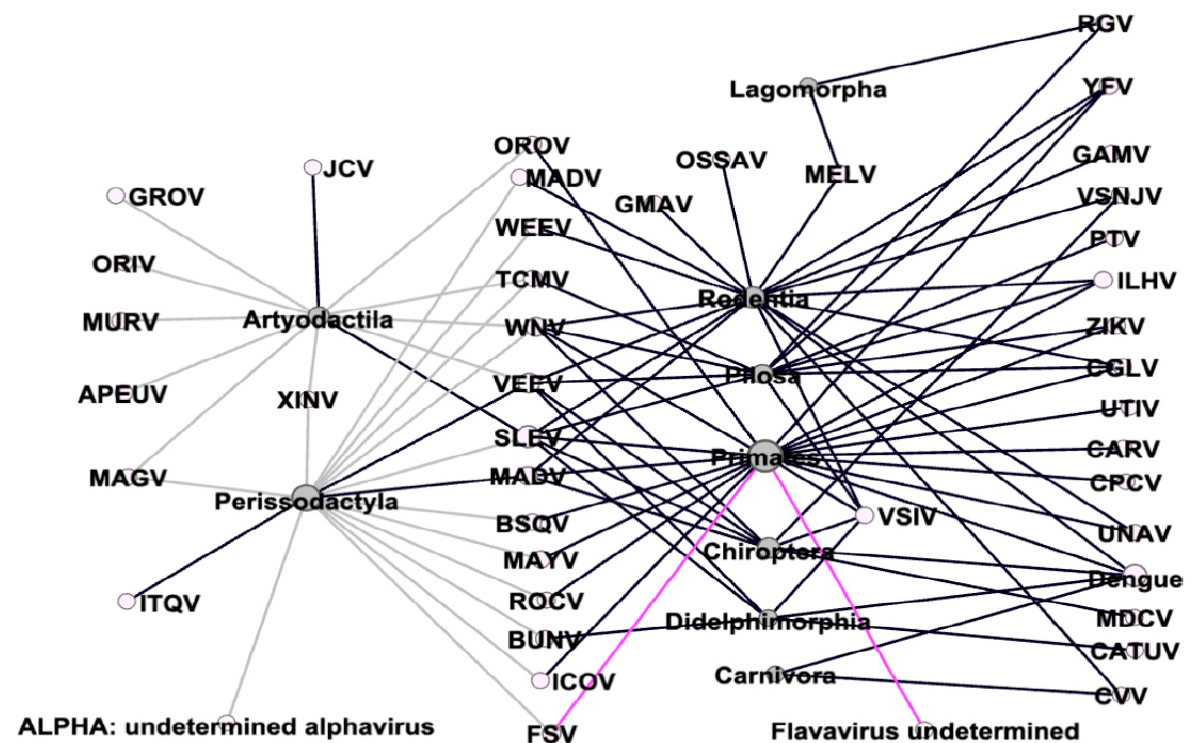
Figure 4. Arbovirus host network in mammals in the Neotropics. Legend: grey link: eomestic envi- ronment, black link: wildlife environment, pink link: zoological settings, grey circles: mammal or- ders, white circles: arbovirus. Note: Apeu virus—APEUV; Bunyamwera virus—BUNV; Bussuquara